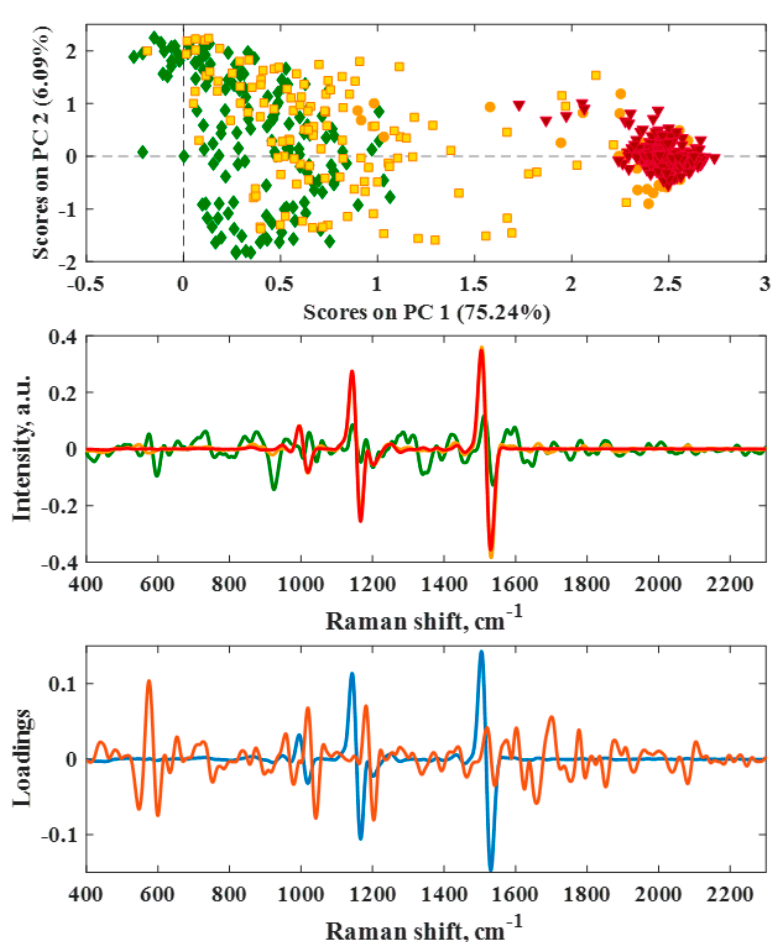
Figure 5. PCA of 1119 spectra from 122 hot pepper samples at different ripeness levels. Top: Scores plot representing the maturity categories fully immature (green spades), immature (yellow squares), harvestable (orange circles) and mature (red triangles). Middle: Averaged preprocessed derivative spectra of immature (green), harvestable (orange) and mature (red) fruits. Bottom: Loading vectors of PC1 (blue, 75.2%) and PC2 (orange, 6.1%).